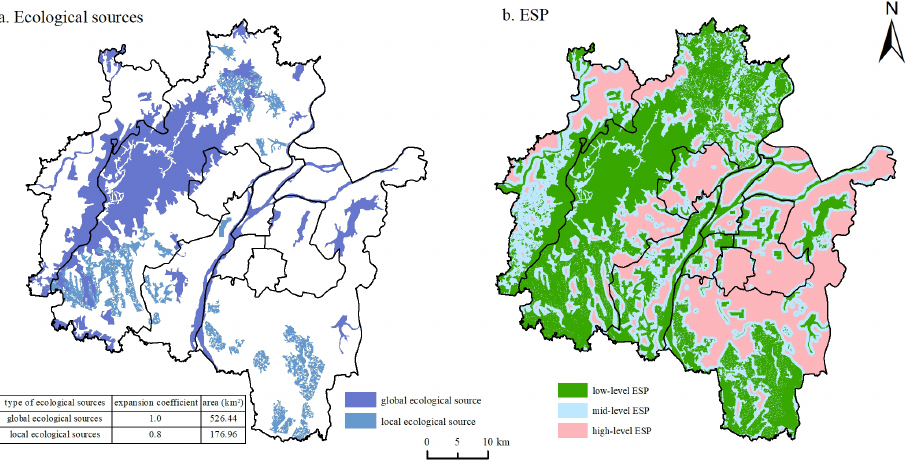
Figure 3. Spatial distribution of the ecological sources identified and the ecological security pattern (ESP) established in the study area in 2018.